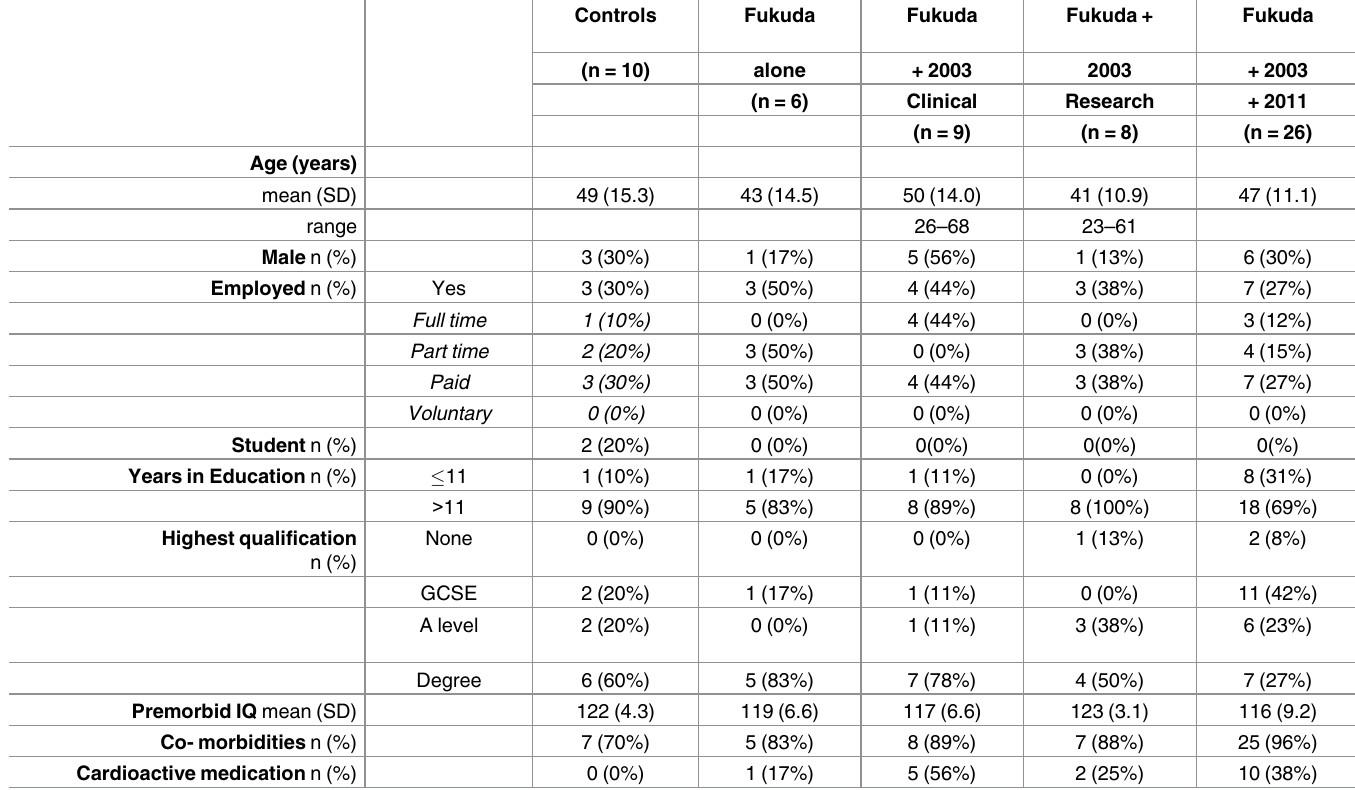
Table 2. Baseline